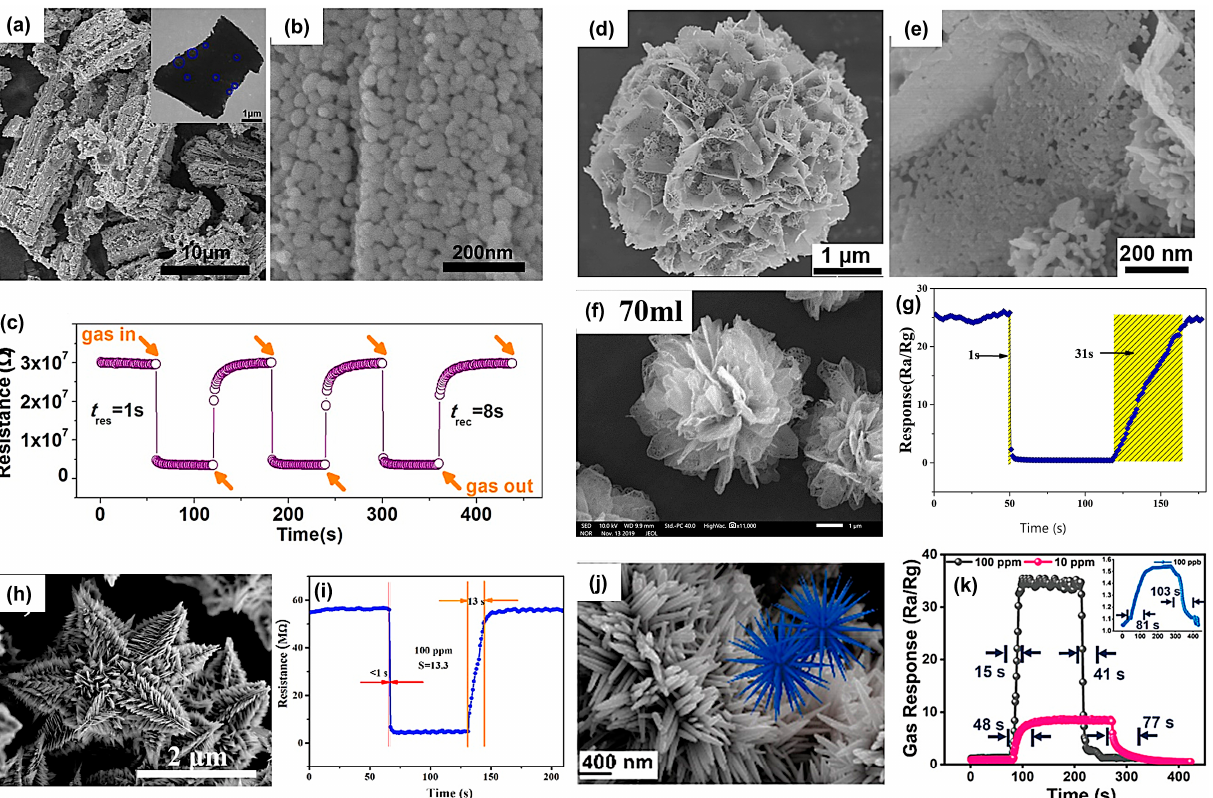
Figure 8. The typical FESEM images ( a , b ) In 2 O 3 hierarchical architectures. The inset is the TEM image of In 2 O 3 hierarchical architectures. ( c ) Transient responses of In 2 O 3 hierarchical architectures to 100 ppm formaldehyde at 260 °C. Reprinted with permission from Ref. [86]. Copyright 2018, Elsevier. SEM images of ( d , e ) 0.3% Pt–SnO 2 . Reprinted with permission from Ref. [87]. Copyright 2020, Elsevier. ( f ) SEM of porous flower-like α -Fe 2 O 3 with 70 mL ethylene glycol. ( g ) Response and recovery curve of α -Fe 2 O 3 with 70 mL ethylene glycol to 100 ppm acetone at operating temperature 210 °C. Reprinted with permission from Ref. [40]. Copyright 2020, Springer. ( h ) FESEM images of the cedar-like SnO 2 micro-nanostructure. ( i ) The transient response of cedar-like SnO 2 sensors exhibits to 100 ppm formaldehyde at 200 °C. Reprinted with permission from Ref. [88]. Copyright 2017, Elsevier. Typical FESEM image of ( j ) Zn-doped layered SnO 2 nanocones sample. (insets) Schematic illustration of the structure unit of the sample. ( k ) The transient response and recovery times of the Zn-doped layered SnO 2 sensor toward three different concentrations of TEA (100 ppb, 10 ppm, and 100 ppm) at 70 °C, 57% RH. Reprinted with permission from Ref. [89]. Copyright 2020, American Chemical Society.